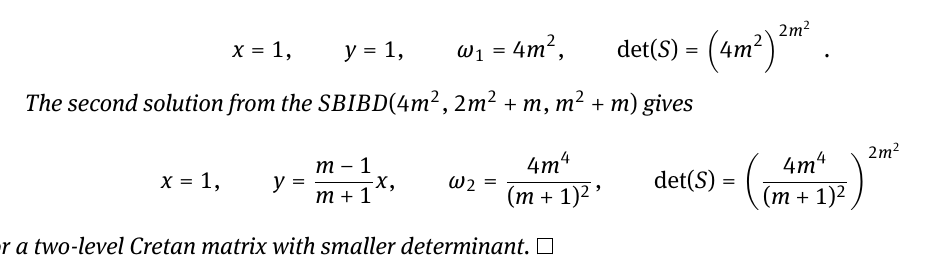
x = 1, y = 1, ω 1 = 4 m 2 , det( S ) =